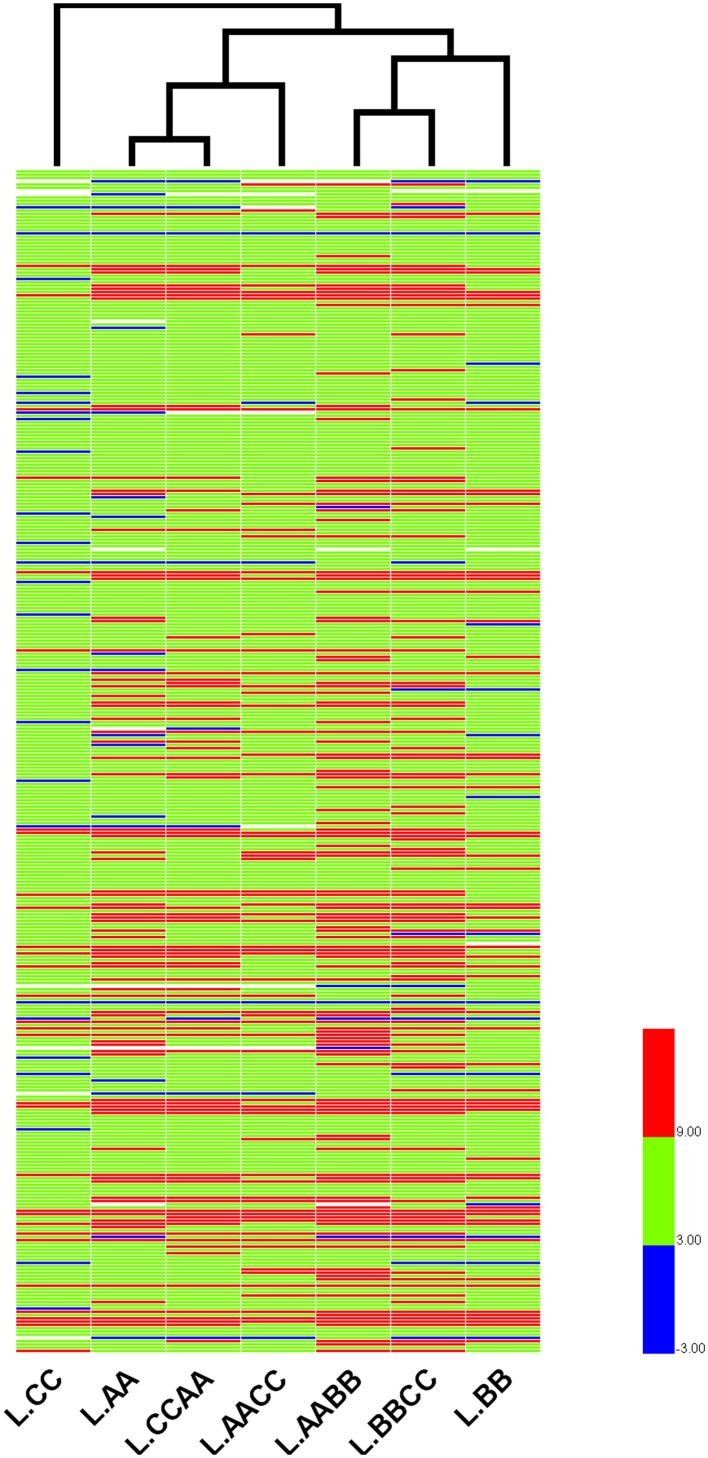
Hierarchical clustering of r-protein genes among allotetraploids and diploids in leaves.